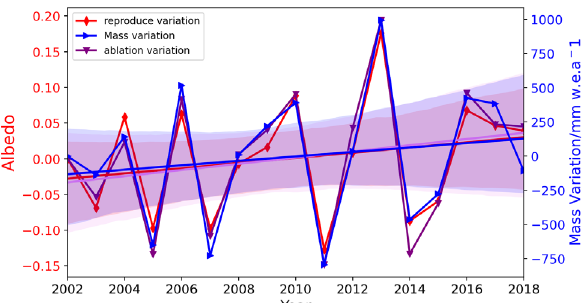
Figure 5. There are difference between glacier mass balance and albedo year-to-year. The red curve is fluctuate of interpolated average albedo, the corresponding straight line is regression line for varation of glacier-wide mean albedo. Using blue curve to depict the variation of interannual mass balance, the blue regression line show tendency of mass loss decrease. The purple line show albedo changing of ablation zone. Light shadow represent a 95% confidence interval, which corresponds with the standard error of the